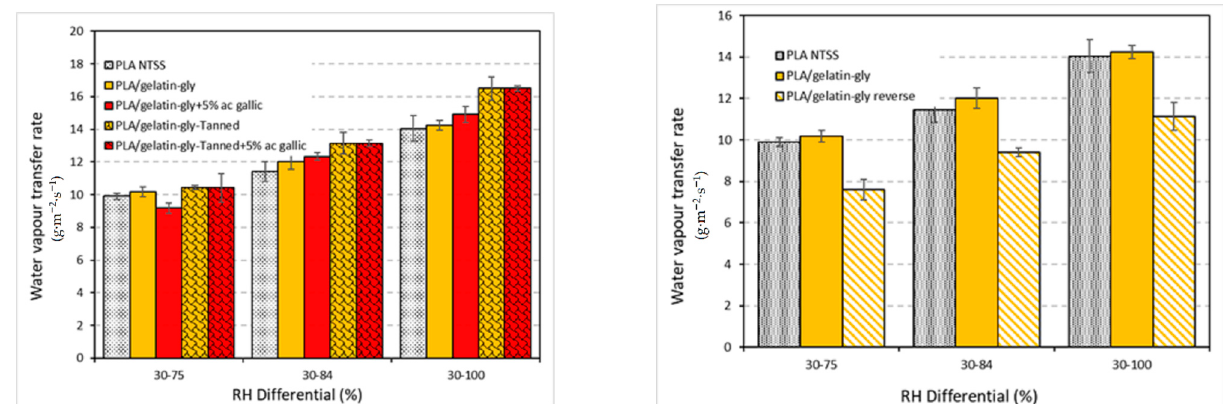
Figure 9. Water vapor transfer rate of the PLA and coated PLA films measured for three relative humidity differentials ( left ) and according to the side exposed to the highest humidity ( right ).